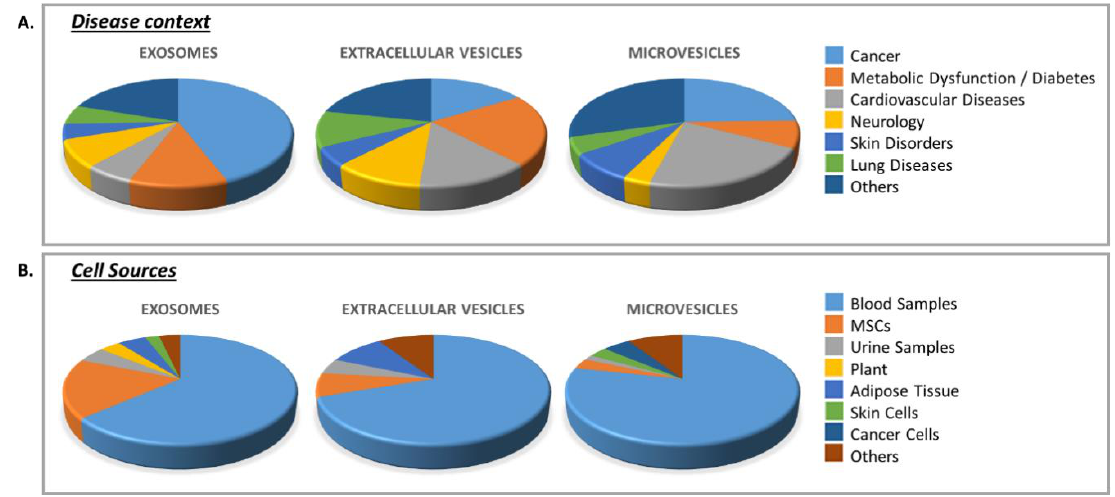
Figure 2. Planned or initiated clinical trials based on EVs. Diagrams representing the proportion of clinical trials targeting a group of diseases ( A ) or using a specific EV source (as biomarker or therapeutic); ( B ). These diagrams were obtained following a database search on the Clinicaltrial.gov website with indicated search terms (exosomes, extracellular vesicles, microvesicles). The majority of clinical trials use EVs as biomarkers from the blood or urine.